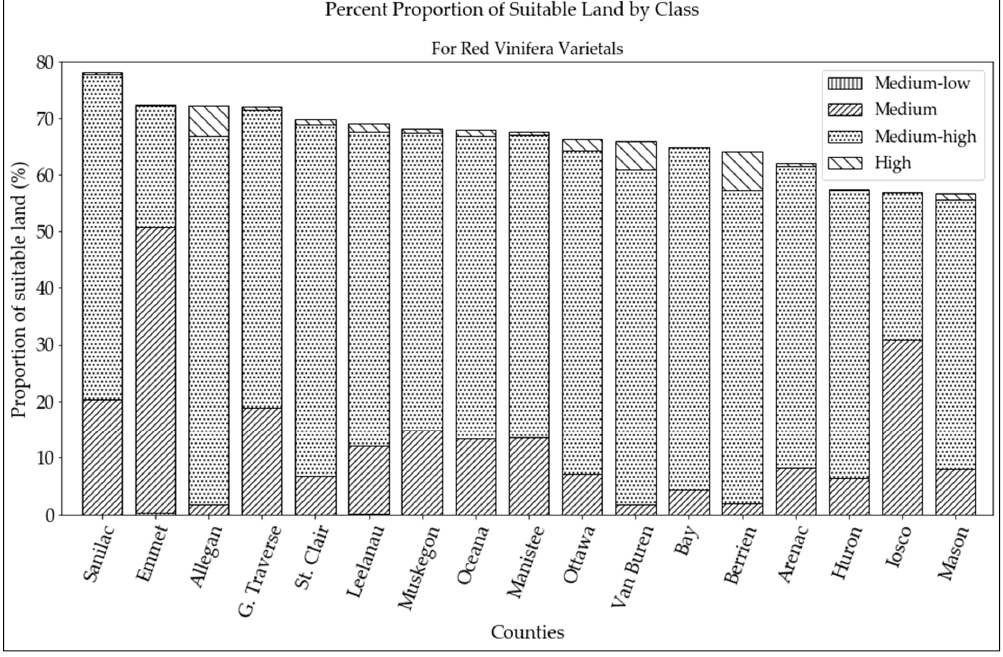
Figure 8. Distribution of land suitability for red vinifera varietals by class. Note that medium-low suitability class is not visible because of the small proportion of land in this class. Note: G. Traverse is Grand Traverse. Atmosphere 2019 , 10 , x FOR PEER REVIEW